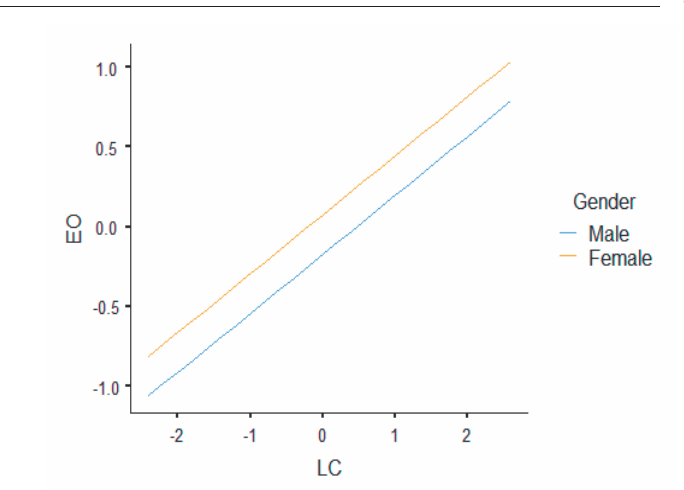
Figure 1. (cid:3)(cid:40)(cid:86)(cid:87)(cid:76)(cid:80)(cid:68)(cid:87)(cid:72)(cid:71)(cid:3)(cid:48)(cid:68)(cid:85)(cid:74)(cid:76)(cid:81)(cid:68)(cid:79)(cid:3)(cid:48)(cid:72)(cid:68)(cid:81)(cid:86)(cid:3)(cid:178)(cid:3)(cid:40)(cid:71)(cid:88)(cid:70)(cid:68)(cid:87)(cid:76)(cid:82)(cid:81)(cid:3)(cid:50)(cid:88)(cid:87)(cid:70)(cid:82)(cid:80)(cid:72)(cid:86)(cid:15)(cid:3)(cid:47)(cid:76)(cid:81)(cid:74)(cid:88)(cid:76)(cid:86)(cid:87)(cid:76)(cid:70)(cid:3) (cid:38)(cid:68)(cid:83)(cid:76)(cid:87)(cid:68)(cid:79)(cid:15)(cid:3)(cid:42)(cid:72)(cid:81)(cid:71)(cid:72)(cid:85)(cid:17) (cid:49)(cid:82)(cid:87)(cid:72) (cid:29)(cid:3)(cid:40)(cid:50)(cid:16)(cid:40)(cid:71)(cid:88)(cid:70)(cid:68)(cid:87)(cid:76)(cid:82)(cid:81)(cid:3)(cid:50)(cid:88)(cid:87)(cid:70)(cid:82)(cid:80)(cid:72)(cid:86)(cid:3)(cid:54)(cid:70)(cid:82)(cid:85)(cid:72)(cid:15)(cid:3)(cid:47)(cid:38)(cid:16)(cid:47)(cid:76)(cid:81)(cid:74)(cid:88)(cid:76)(cid:86)(cid:87)(cid:76)(cid:70)(cid:3)(cid:38)(cid:68)(cid:83)(cid:76)(cid:87)(cid:68)(cid:79)(cid:3)(cid:54)(cid:70)(cid:82)(cid:85)(cid:72)(cid:17) (cid:36)(cid:3)(cid:86)(cid:76)(cid:80)(cid:76)(cid:79)(cid:68)(cid:85)(cid:3)(cid:68)(cid:81)(cid:68)(cid:79)(cid:92)(cid:86)(cid:76)(cid:86)(cid:3)(cid:90)(cid:68)(cid:86)(cid:3)(cid:70)(cid:82)(cid:81)(cid:71)(cid:88)(cid:70)(cid:87)(cid:72)(cid:71)(cid:3)(cid:87)(cid:82)(cid:3)(cid:87)(cid:72)(cid:86)(cid:87)(cid:3)(cid:87)(cid:75)(cid:72)(cid:3)(cid:76)(cid:80)(cid:83)(cid:68)(cid:70)(cid:87)(cid:3)(cid:82)(cid:73)(cid:3)(cid:79)(cid:76)(cid:81)(cid:74)(cid:88)(cid:76)(cid:86)(cid:87)(cid:76)(cid:70)(cid:3)(cid:70)(cid:68)(cid:83)(cid:76)(cid:87)(cid:68)(cid:79)(cid:3)(cid:68)(cid:81)(cid:71)(cid:3) (cid:74)(cid:72)(cid:81)(cid:71)(cid:72)(cid:85)(cid:3)(cid:82)(cid:81)(cid:3)(cid:87)(cid:75)(cid:72)(cid:3)(cid:86)(cid:87)(cid:88)(cid:71)(cid:92)(cid:3)(cid:85)(cid:72)(cid:86)(cid:88)(cid:79)(cid:87)(cid:86)(cid:3)(cid:68)(cid:81)(cid:71)(cid:3)(cid:86)(cid:70)(cid:76)(cid:72)(cid:81)(cid:87)(cid:76)(cid:192)(cid:70)(cid:3)(cid:68)(cid:70)(cid:87)(cid:76)(cid:89)(cid:76)(cid:87)(cid:92)(cid:3)(cid:82)(cid:73)(cid:3)(cid:87)(cid:75)(cid:72)(cid:3)(cid:86)(cid:87)(cid:88)(cid:71)(cid:72)(cid:81)(cid:87)(cid:86)(cid:17)(cid:3)(cid:53)(cid:72)(cid:86)(cid:88)(cid:79)(cid:87)(cid:86)(cid:3)(cid:82)(cid:73)(cid:3) (cid:79)(cid:76)(cid:81)(cid:72)(cid:68)(cid:85)(cid:3) (cid:85)(cid:72)(cid:74)(cid:85)(cid:72)(cid:86)(cid:86)(cid:76)(cid:82)(cid:81)(cid:3) (cid:73)(cid:82)(cid:85)(cid:3) (cid:86)(cid:87)(cid:88)(cid:71)(cid:92)(cid:3) (cid:85)(cid:72)(cid:86)(cid:88)(cid:79)(cid:87)(cid:86)(cid:3) (cid:76)(cid:81)(cid:71)(cid:76)(cid:70)(cid:68)(cid:87)(cid:72)(cid:3) (cid:87)(cid:75)(cid:68)(cid:87)(cid:3) (cid:87)(cid:75)(cid:72)(cid:3) (cid:70)(cid:82)(cid:81)(cid:86)(cid:87)(cid:85)(cid:88)(cid:70)(cid:87)(cid:72)(cid:71)(cid:3) (cid:80)(cid:82)(cid:71)(cid:72)(cid:79)(cid:3) (cid:11)(cid:41)(cid:11)(cid:21)(cid:15)(cid:3) (cid:21)(cid:22)(cid:21)(cid:12)(cid:32)(cid:23)(cid:17)(cid:26)(cid:25)(cid:15)(cid:3) (cid:53)(cid:242)(cid:32)(cid:17)(cid:19)(cid:23)(cid:15)(cid:3) (cid:83)(cid:32)(cid:17)(cid:19)(cid:19)(cid:28)(cid:12)(cid:3) (cid:83)(cid:85)(cid:82)(cid:89)(cid:72)(cid:86)(cid:86)(cid:3) (cid:86)(cid:76)(cid:74)(cid:81)(cid:76)(cid:192)(cid:70)(cid:68)(cid:81)(cid:87)(cid:15)(cid:3) (cid:83)(cid:82)(cid:76)(cid:81)(cid:87)(cid:76)(cid:81)(cid:74)(cid:3) (cid:82)(cid:88)(cid:87)(cid:3) (cid:79)(cid:76)(cid:81)(cid:74)(cid:88)(cid:76)(cid:86)(cid:87)(cid:76)(cid:70)(cid:3) (cid:70)(cid:68)(cid:83)(cid:76)(cid:87)(cid:68)(cid:79)(cid:3) (cid:11)(cid:87)(cid:32)(cid:21)(cid:17)(cid:20)(cid:27)(cid:15)(cid:3)(cid:83)(cid:32)(cid:17)(cid:19)(cid:22)(cid:19)(cid:12)(cid:3)(cid:68)(cid:81)(cid:71)(cid:3)(cid:74)(cid:72)(cid:81)(cid:71)(cid:72)(cid:85)(cid:3)(cid:11)(cid:87)(cid:32)(cid:16)(cid:21)(cid:17)(cid:19)(cid:25)(cid:15)(cid:3)(cid:83)(cid:32)(cid:17)(cid:19)(cid:23)(cid:20)(cid:12)(cid:3)(cid:68)(cid:86)(cid:3)(cid:86)(cid:76)(cid:74)(cid:81)(cid:76)(cid:192)(cid:70)(cid:68)(cid:81)(cid:87)(cid:3)(cid:83)(cid:85)(cid:72)(cid:71)(cid:76)(cid:70)(cid:87)(cid:82)(cid:85)(cid:86)(cid:3)(cid:11)(cid:41)(cid:76)(cid:74)(cid:88)(cid:85)(cid:72)(cid:3)(cid:21)(cid:12)(cid:17)